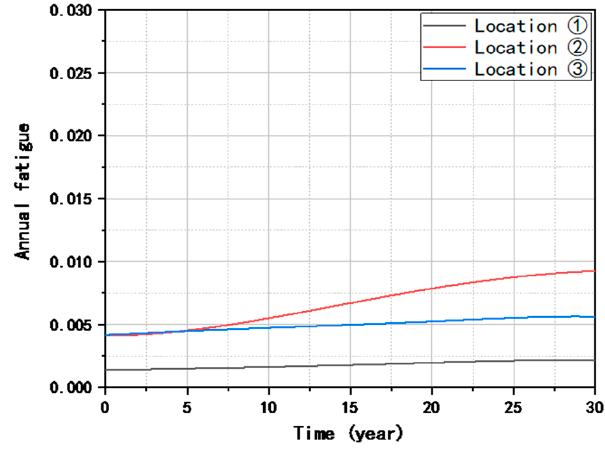
Figure 8. Accumulated fatigue damage of tubular joints under wave loads.